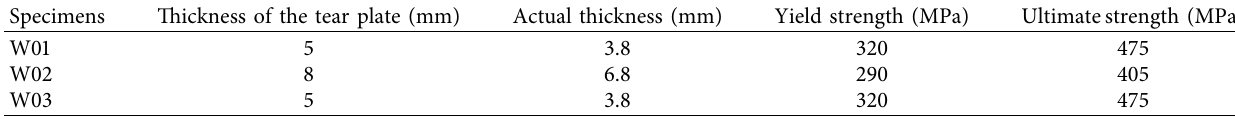
Table 2: Material properties of the steel plate